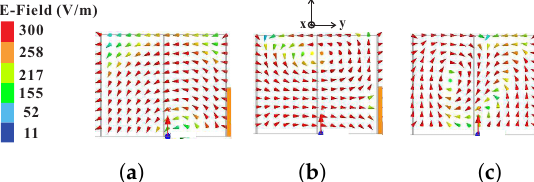
Figure 3. Comparison of Design-A, Design-B, and Design-C in terms of ( a ) the reflection coefficients, and ( b ) the axial ratios.